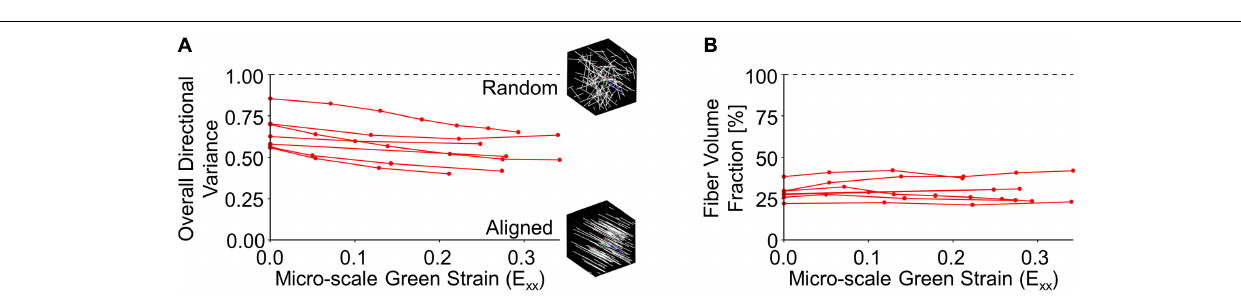
Frontiers in Bioengineering and Biotechnology |